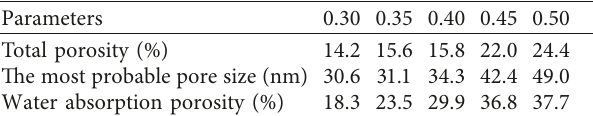
Figure 6: MIP testing results of specimens with different w / c . Table 4: Parameters of pore